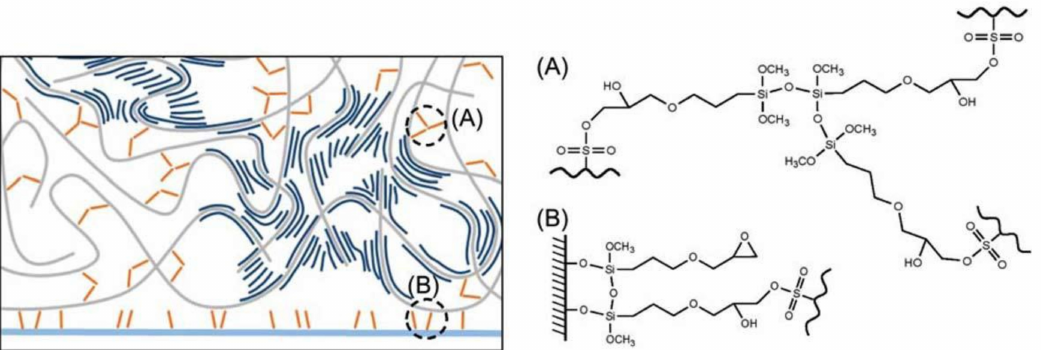
Figure 8. Schematic illustration of the system of GOPS-crosslinked PEDOT:PSS. GOPS is only reacting with the parts of the PSS-chains (gray), not interacting with PEDOT (dark blue). The zoom in shows three main interactions involving GOPS; GOPS-PSS, GOPS-GOPS and GOPS-glass. ( A ) The chemical bonds between ASO3H group of PSS and the epoxy ring of GOPS, as well as the chemical bond between three GOPS molecules. ( B ) The chemical bond between hydroxyl groups at the glass surface and the methoxysilane groups of GOPS. Reproduced from [82] with permission from John Wiley and Sons, Copyright ©